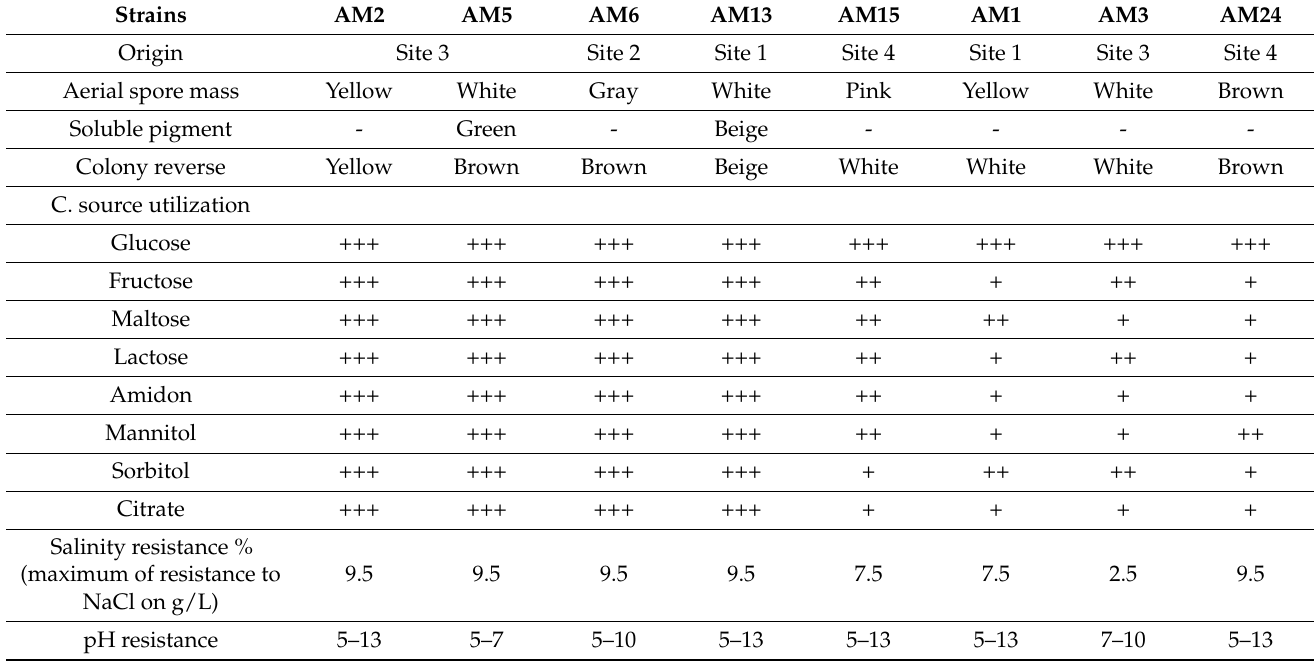
Table 2. Biochemical and morphological characteristics of the eight selected